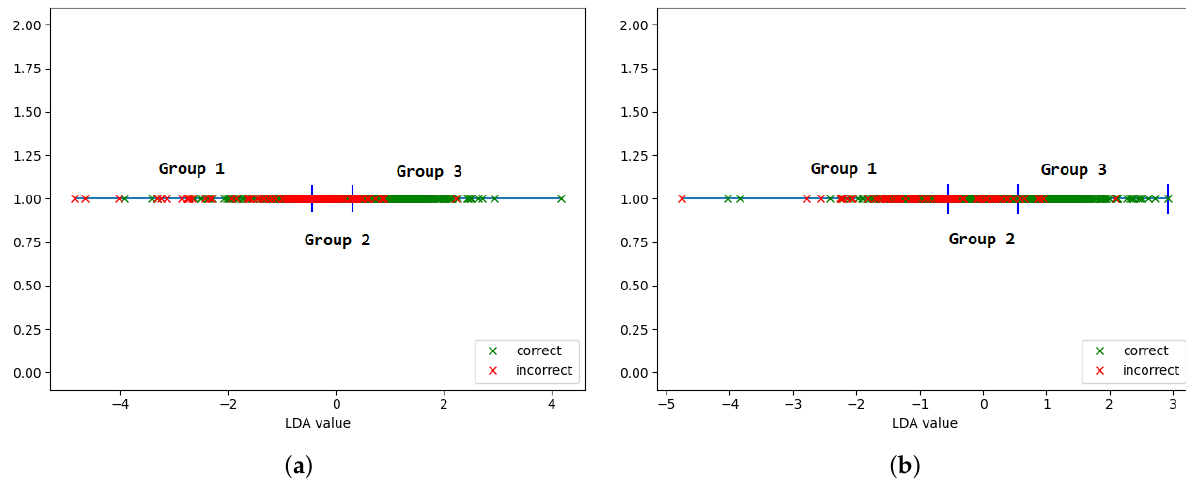
Figure 10. Grouping based on LDA subspace separating inputs by “correctness” of classification. The LDA label for each sample is obtained as the majority vote for correctly vs. incorrectly classified across all the network’s compression levels. ( a ) Any-Precision. ( b )